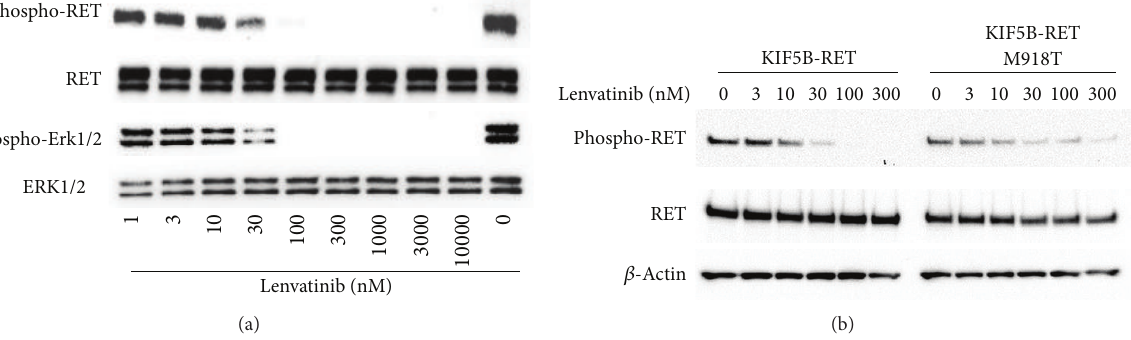
Figure5:EffectoflenvatinibonthephosphorylationofRETwithanactivatingmutationorarearrangementinvitro.(a)Westernblotanalyses of the phosphorylation of RET in human medullary thyroid TT cells. TT cells were seeded and cultured overnight. They were then treated with lenvatinib at the indicated concentrations for 1h before being lysed. (b) Western blot analyses of the phosphorylation of KIF5B-RET fusion proteins in normal thyroid cells; Nthy-ori 3-1 transfectants overexpressing KIF5B-RET (wild-type) or KIF5B-RET (M918T). Nthy-ori 3-1 transfectants were cultured overnight and then treated with lenvatinib at the indicated concentrations for 1 h before being lysed. Western blotanalysesofthephosphorylationofRETanditsdownstreameffectorsinNthy-ori3-1transfectantswerethenperformedandrepresentative images were